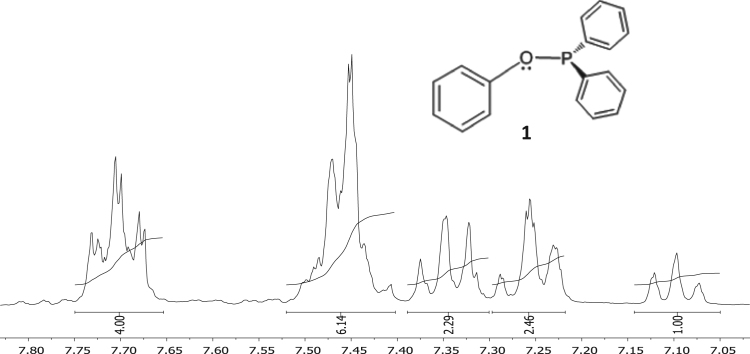
1H NMR of phenyl diphenylphosphinite, C6H5OPPh2, 1.